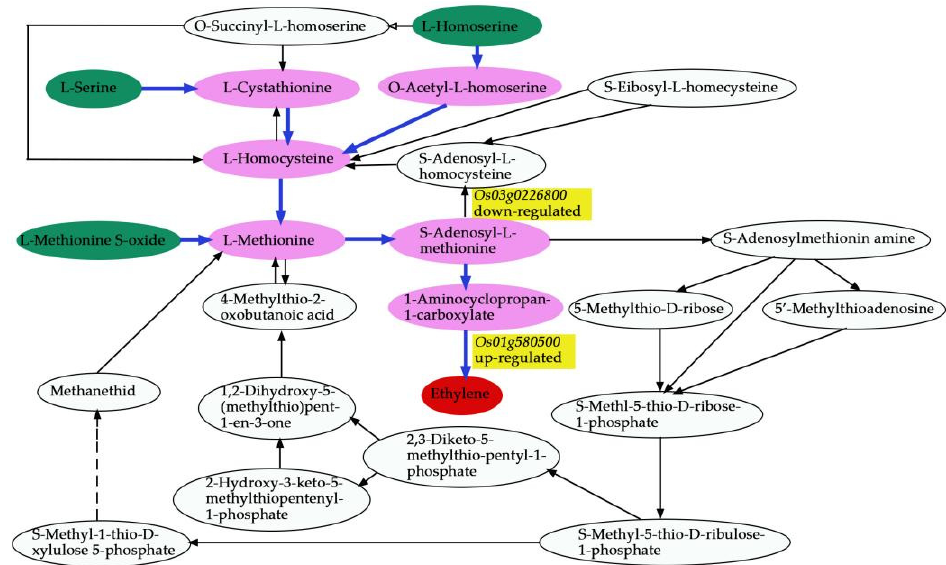
Figure 15. Ethylene formation from L-Serine, L-Homoserine, and L-Methionine